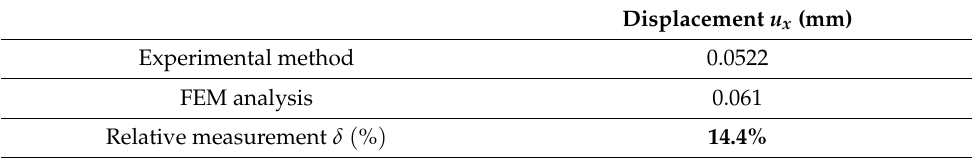
Table 9. Results for the sample with lamination angles ± 30 ◦ .